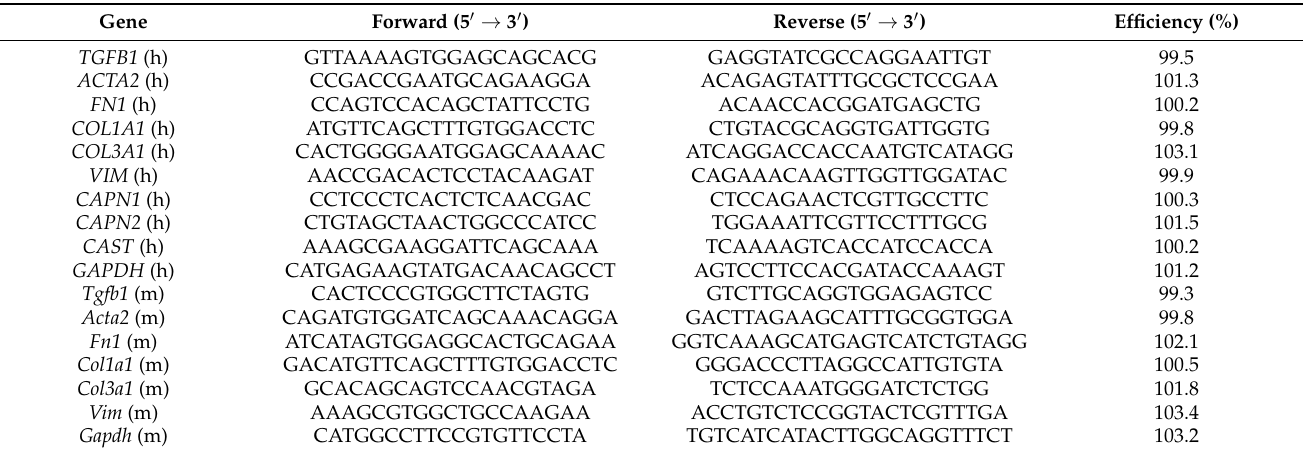
Table 2. The qRT-PCR primer